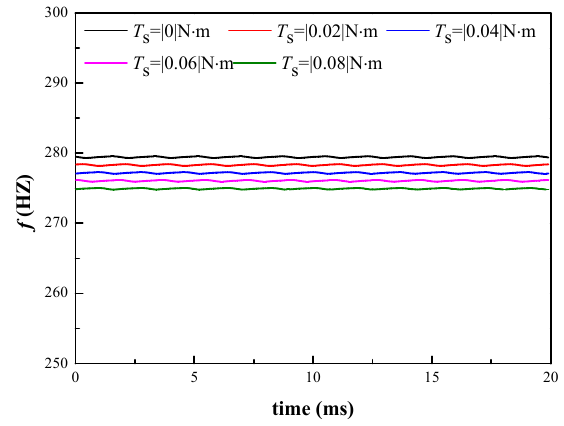
Figure 32. Reversing frequencies of different transient flow torques.